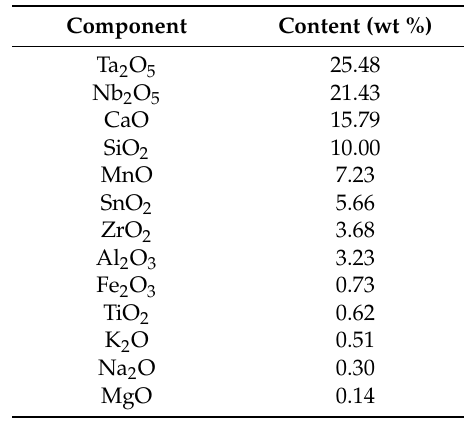
Table 6. Chemical composition of the slag (expressed at wt % of oxides).